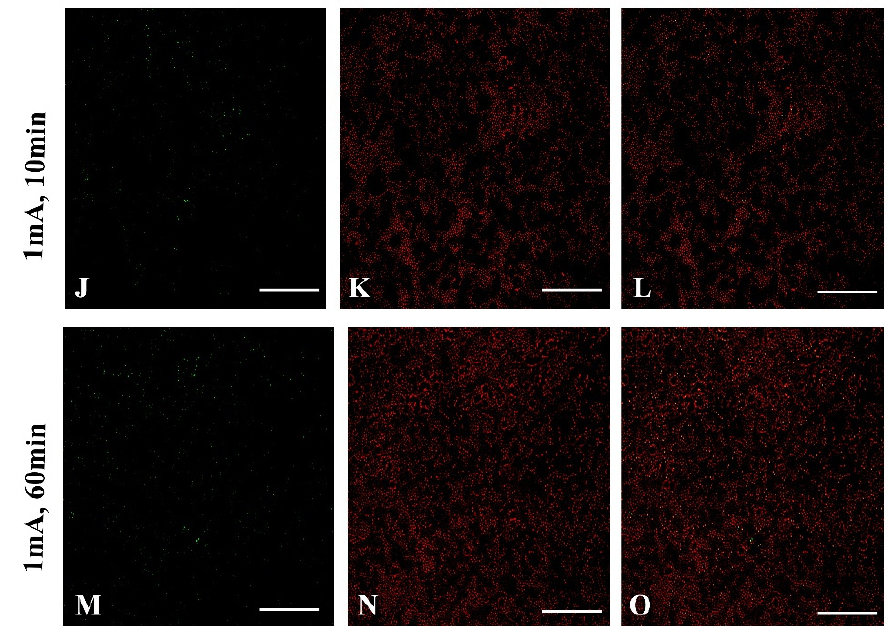
Figure 5. Fluorescence microscopy images of Live/Dead of S. aureus of biofilm eradication assay with low amperage electric current electrical stimulation, the green fluorescence (SYTO 9) indicates the live bacteria and red fluorescence (potassium iodide, PI) indicates the dead bacteria. (Scale bar = 50 µ m). Control samples: ( A ) SYTO 9, live bacteria, ( B ) PI, dead bacteria, ( C ) a merged image of both types of staining; 10 mA after 10 min. ( D ) SYTO 9, ( E ) PI, ( F ) merged images; 10 mA after 60 min. ( G ) SYTO 9, ( H ) PI, ( I ) merged images; 1 mA after 10 min. ( J ) SYTO 9, ( K ) PI, ( L ) merged images; 1 mA after 60 min. ( M ) SYTO 9, ( N ) PI, ( O ) merged